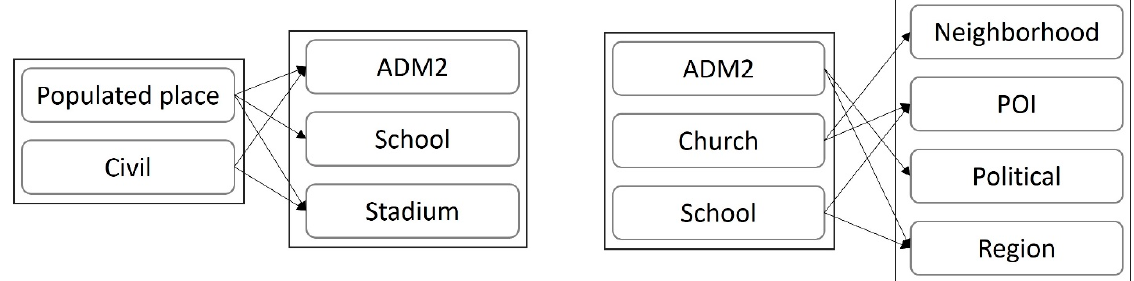
Figure 9. Place types matching between GNIS and GeoNames ( left ) and GeoNames and Google Places ( right ) based on the thematic characteristics.